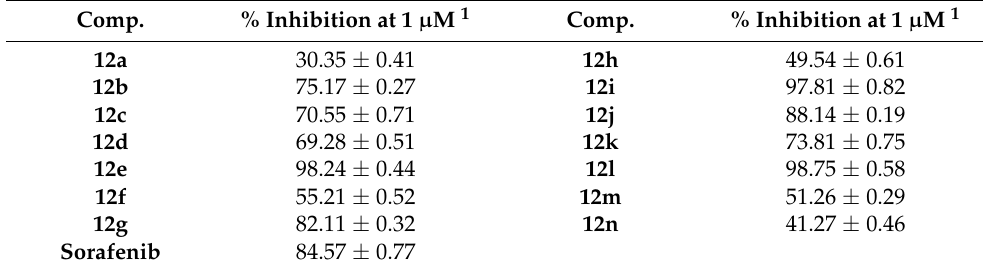
Table 2. Percent inhibition of compound 12a-n over V600EBRAF at single dose (1 µ M).